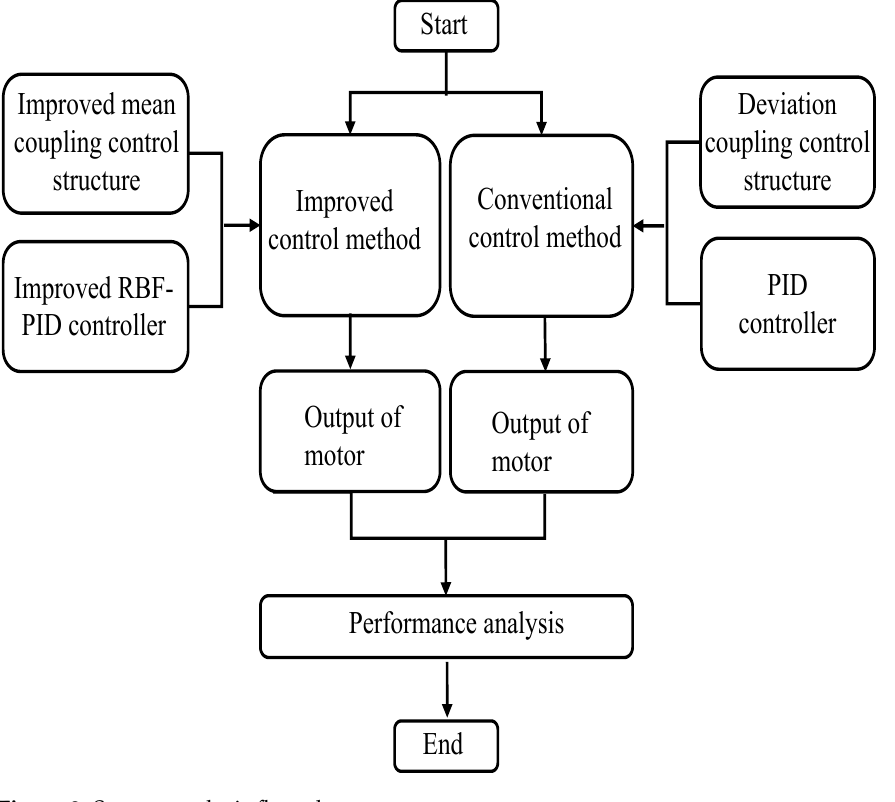
Figure 9. System analysis flow